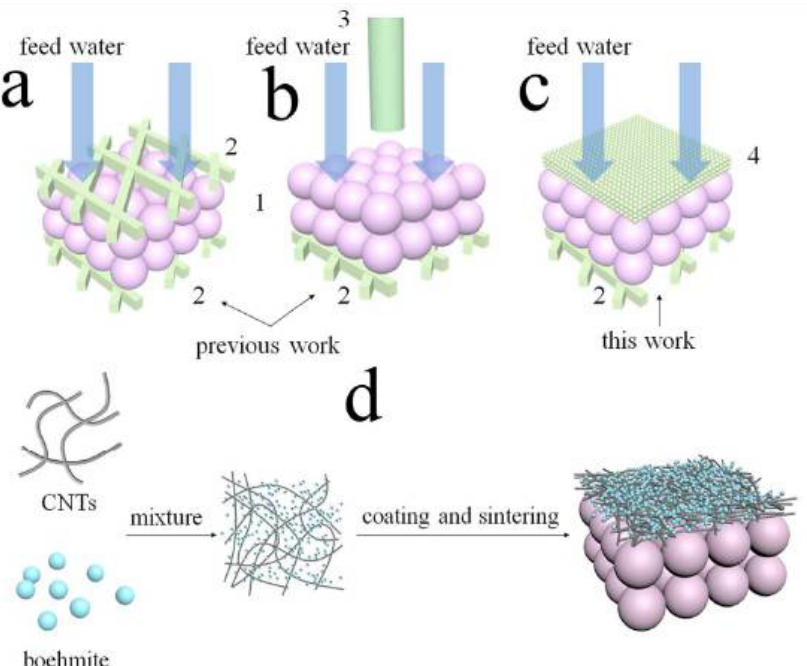
Figure 15. ( a – c ) Cross flow membrane module schematic for membrane operation with in-situ ultrasonic generation: (1) symmetric piezoelectric membrane, (2) permeate side mesh electrode, (3) distant rod electrode, and (4) asymmetric structure with conductive membrane layer and piezoelectric support; ( d ) Process of making a composite membrane [106].